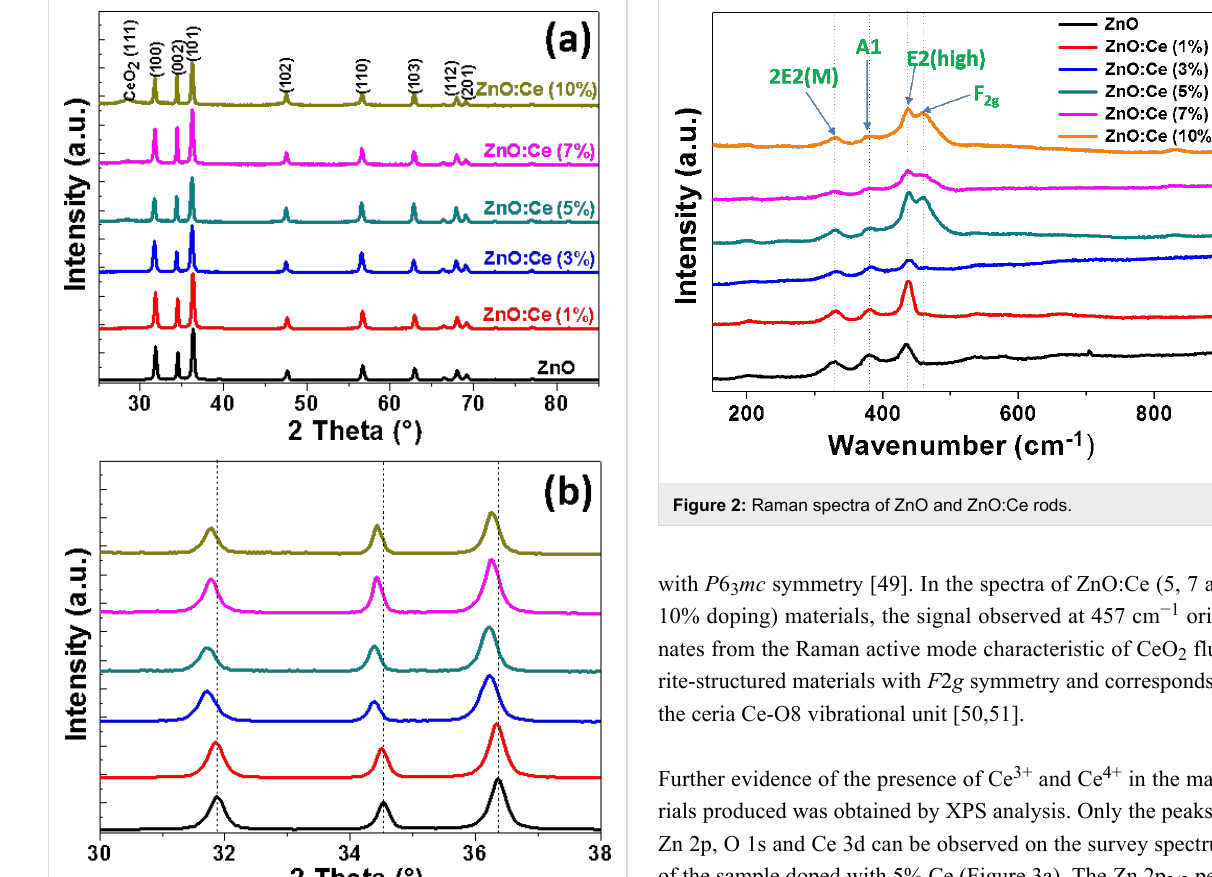
Zn 2+ sites or interstitial sites in the ZnO lattice, the angle shift of the (100), (002) and (101) peaks as a function of doping per-